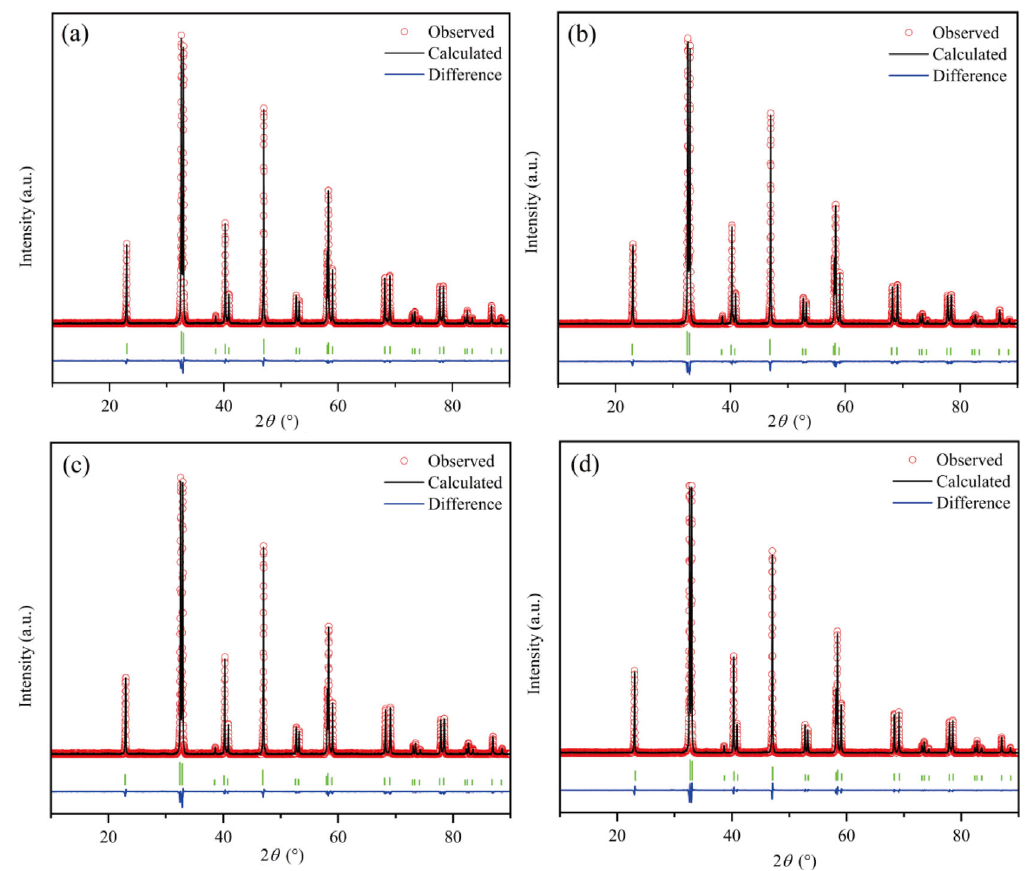
Fig. 3 Rietveld-refined XRD patterns of La(CoCrFeMnNiAl x ) 1/(5+ x ) O 3 − δ : (a) x = 0.4, (b) x = 0.5, (c) x = 0.6, and (d) x = 0.7. Table 1 Calculated lattice constants of the obtained La(CoCrFeMnNiAl x ) 1/(5+ x ) O 3 − δ perovskite materials Composition a (10 − 10 m) b (10 − 10 m) c (10 − 10 m) Normalized cell volume (Å 3 ) a 0 (Å)